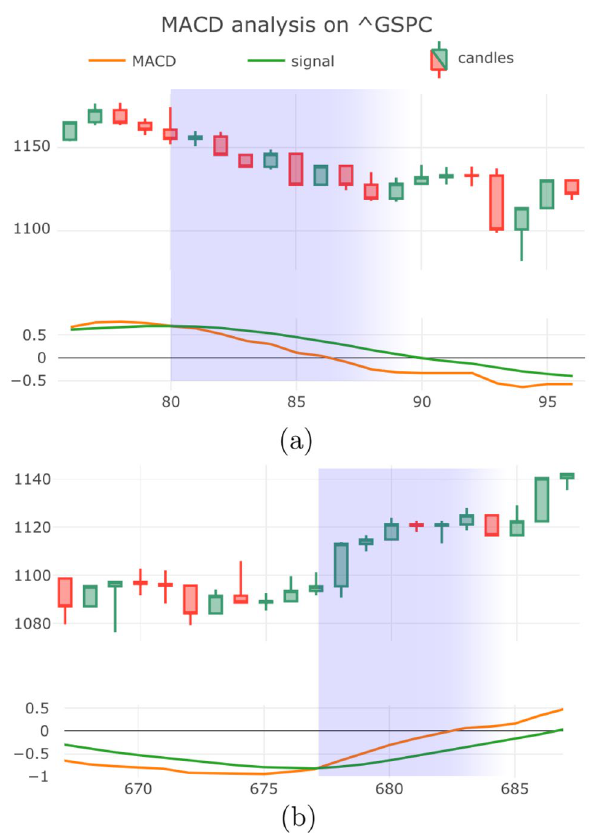
Figure 6. Examples of successful MACD signals, showing number of new COVID cases (y-axis) as a function of time in weeks from the first case. Panel ( a ) shows the MACD crossing the signal from line below, leading to bullish reversal. Panel ( b ) shows the converse bearish MACD